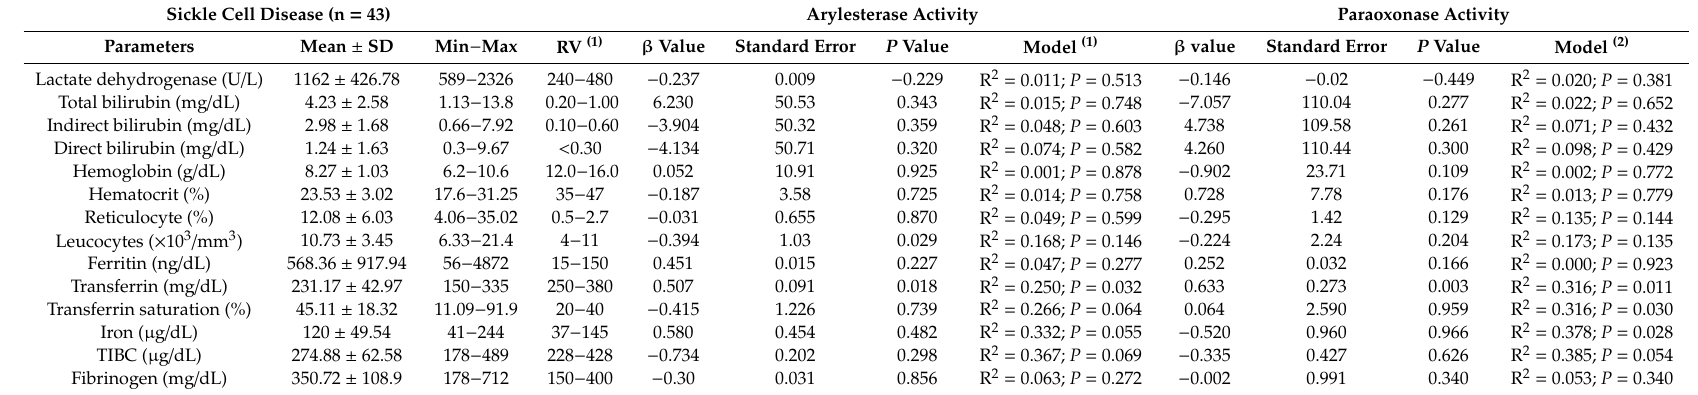
Table 4. Relationship between biochemical parameters and PON-1 arylesterase and paraoxonase